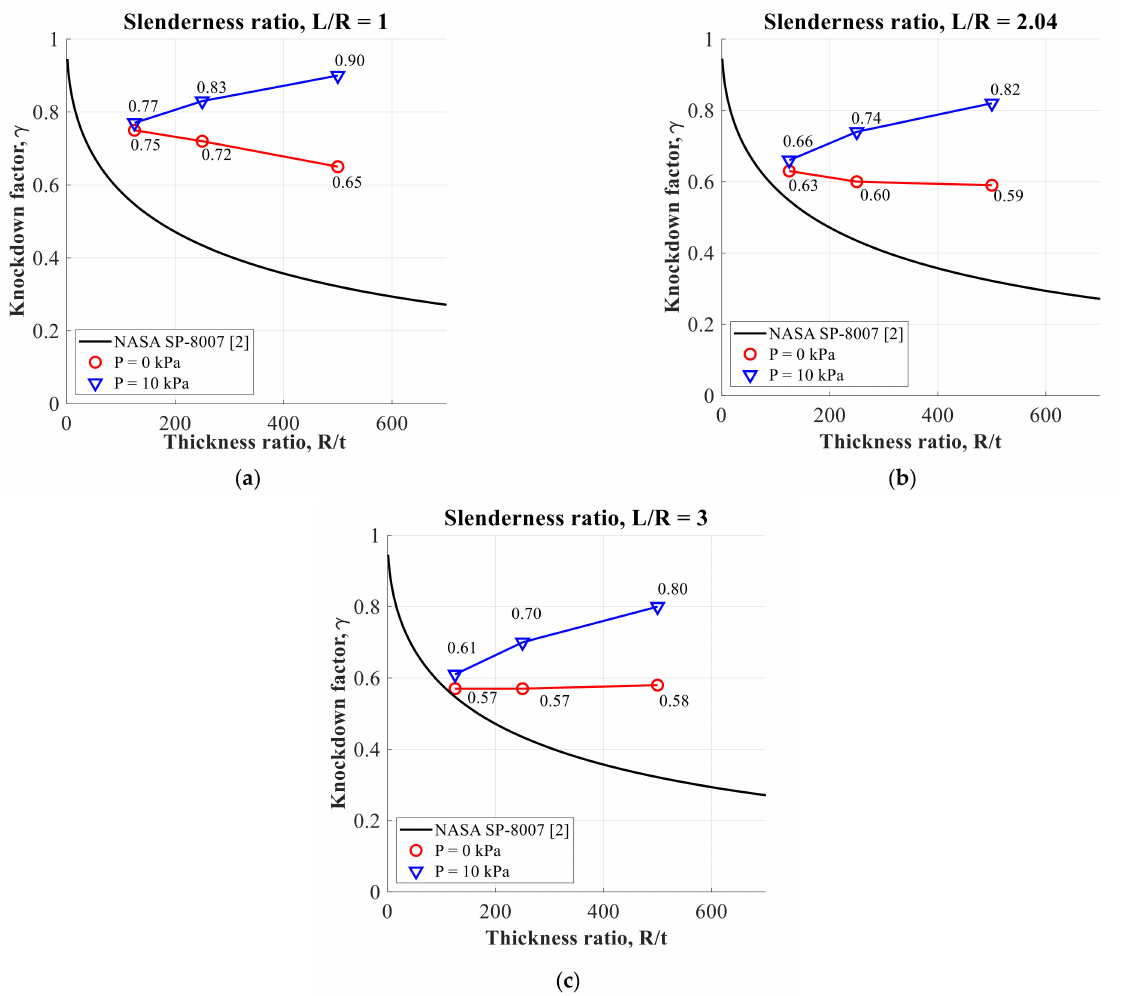
Figure 13. Buckling knockdown factors of the thin-walled composite tank models considering various geometric properties with and without the internal pressure. ( a ) L / R = 1, ( b ) L / R = 2.04, ( c ) L / R =